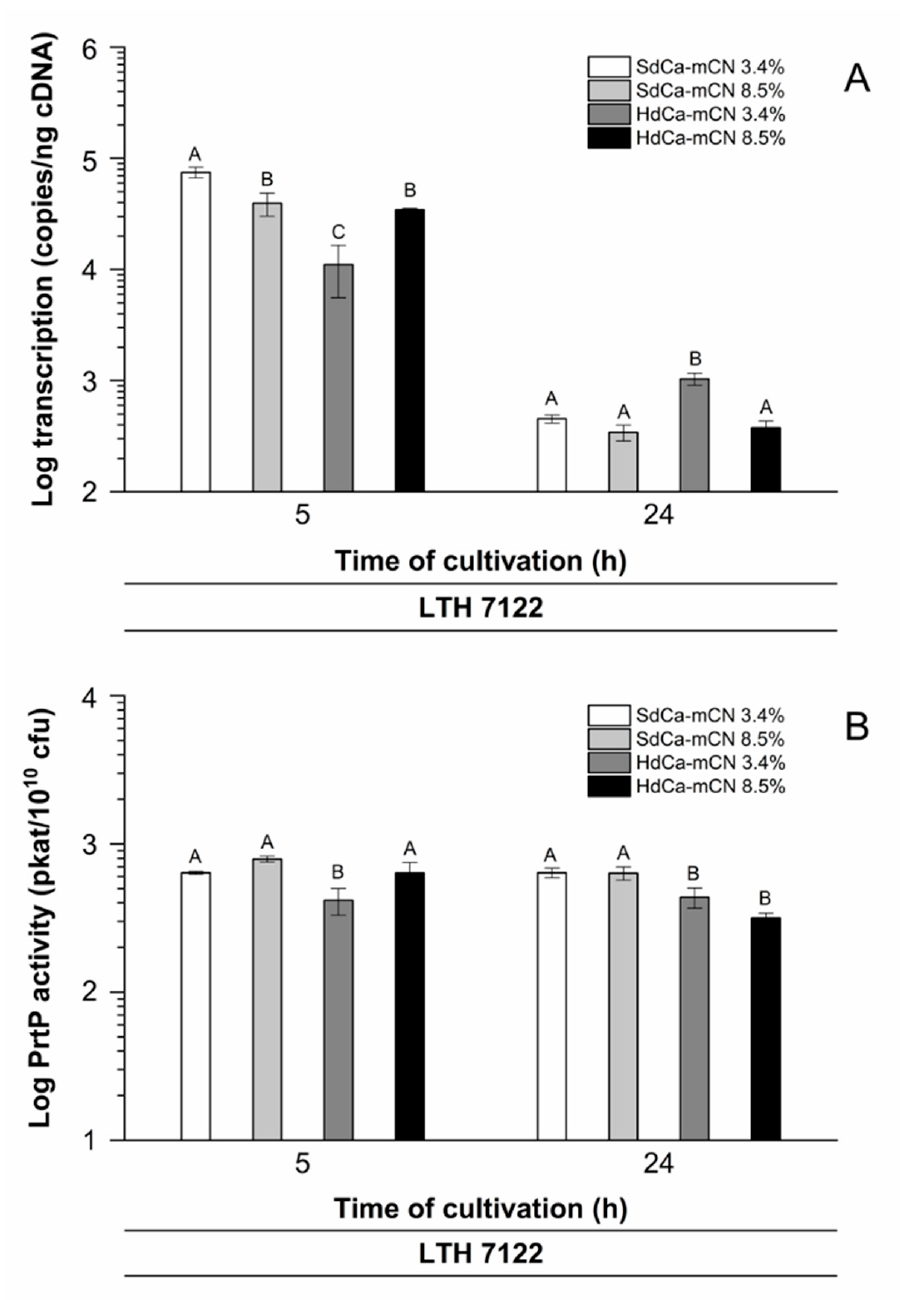
Figure 5. prtP transcription ( A ) and PrtP peptidase activity ( B ) of strain L. lactis LTH 7122 during cultivation in slightly calcium-reduced (SdCa-mCN) and highly calcium-reduced reconstituted casein medium (HdCa-mCN), each with a protein concentration of 3.4% ( w / v ) and 8.5% ( w / v ). Samples were collected after 5 h and 24 h of cultivation. The mean values and standard deviations of at least two biological replicates each are shown. ( A – C ): bars with different uppercase letters are significantly different ( p < 0.05).